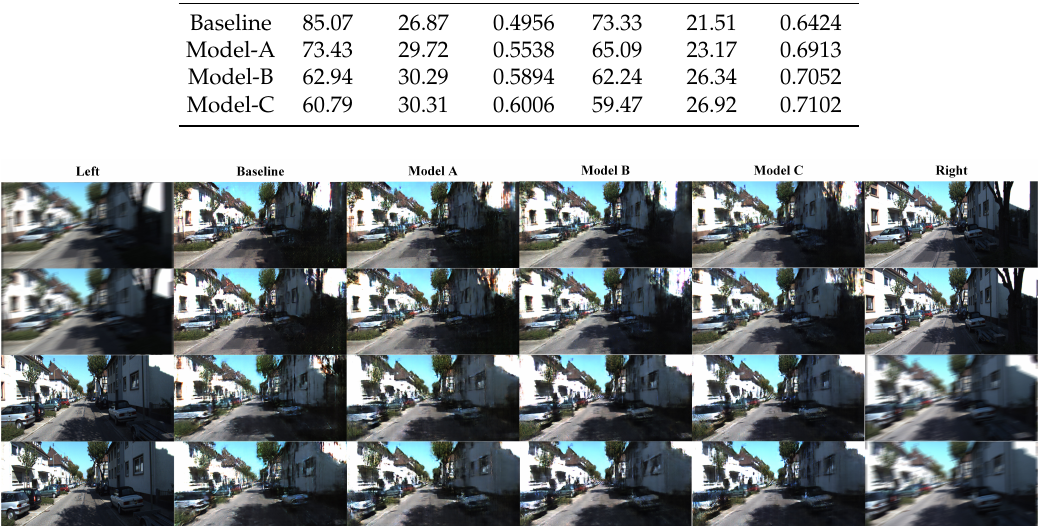
Figure 13. Virtual view reconstruction based on blurred images. The top two rows are based on blurred left image sand the bottom two rows are based on blurred right